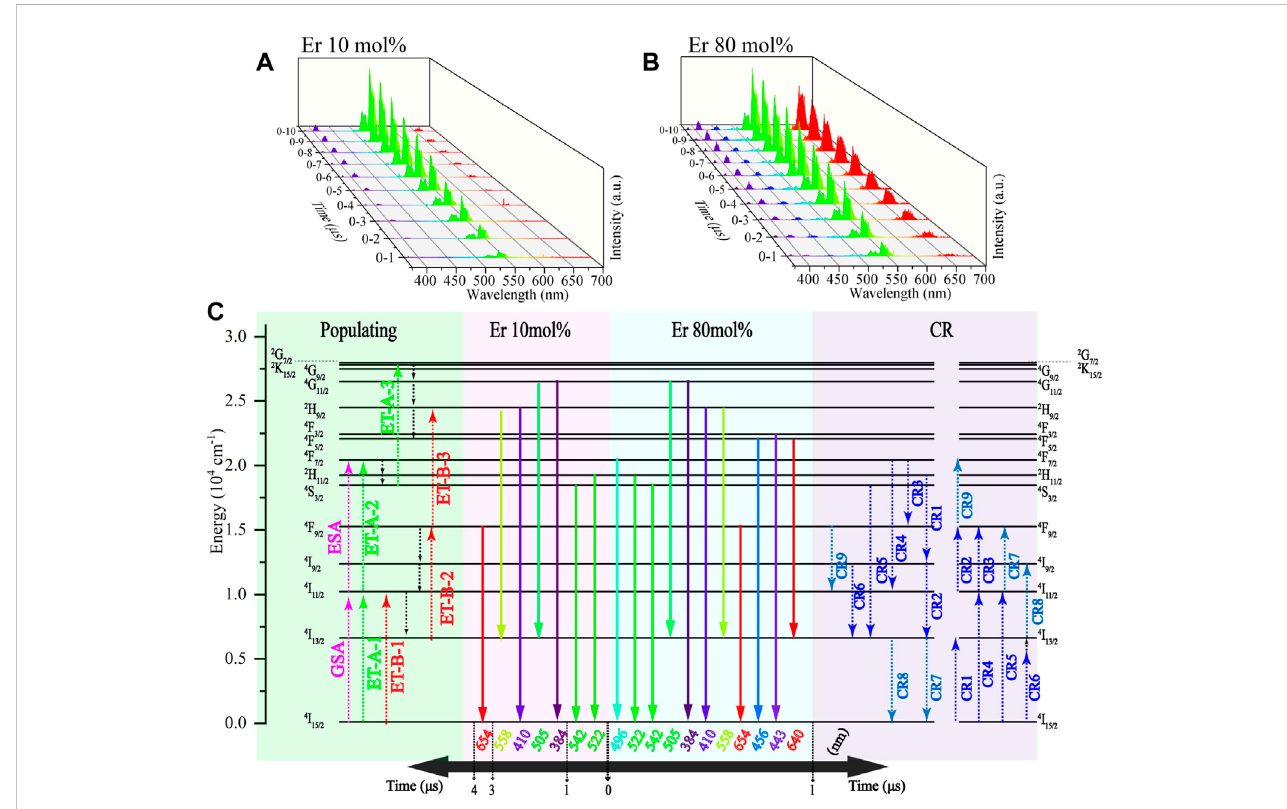
FIGURE 5 NaYF 4 :Er 3+ evolutionspectrumunder976 nmpulseexcitation: (A) Er10 mol%and (B) Er80 mol%. (C) Schematic representationofthetransitionkinetics in NaYF 4 :Yb 3+ /Er 3+ (00/x mol%) with different Er 3+ doping concentrations under 976 nm pulse excitation. Green part is the populating process. Red part is the radiativetransitionprocessat x =10.Bluepartistheradiativetransitionprocessat x =80.PurplepartistheCRprocess.The976 nmns-pulsedexcitationstarts from the 0 moment.